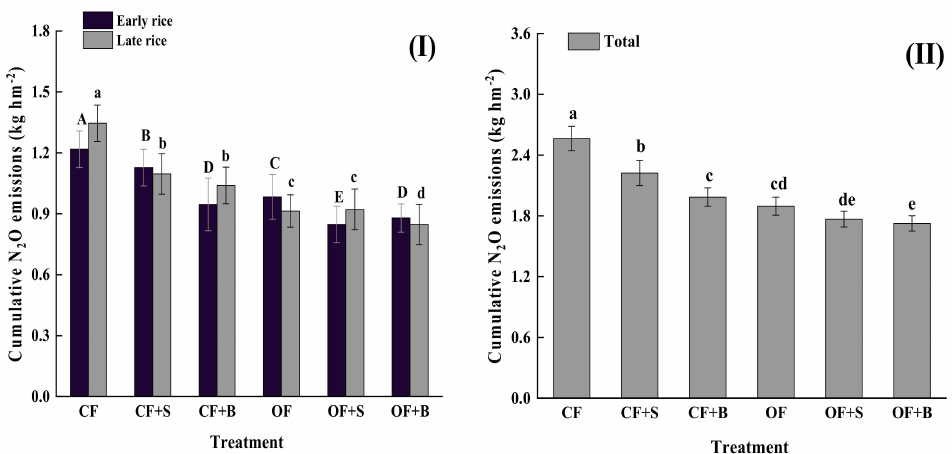
Figure 4. Cumulative N 2 O emissions of early rice/late rice ( I ) and the total ( II ) in the double rice cropping system under different treatments. Error bars represent standard deviations ( n = 3). Uppercase and lowercase letters indicate significant differences at the 0.05 level between treatments in early and late rice seasons.